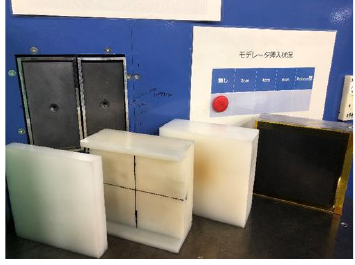
Fig.4 Four kinds of thermal moderator of RANS. Case 2 to case 5 from left to right.